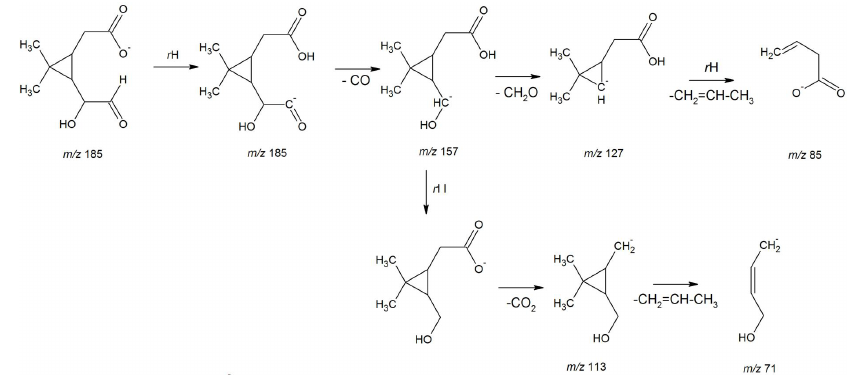
Figure 6. Proposed MS 2 fragmentation mechanism of OH-3-caralic acid. 2 3 Fig. 6. Proposed MS 2 fragmentation mechanism of OH-3-caralic acid.